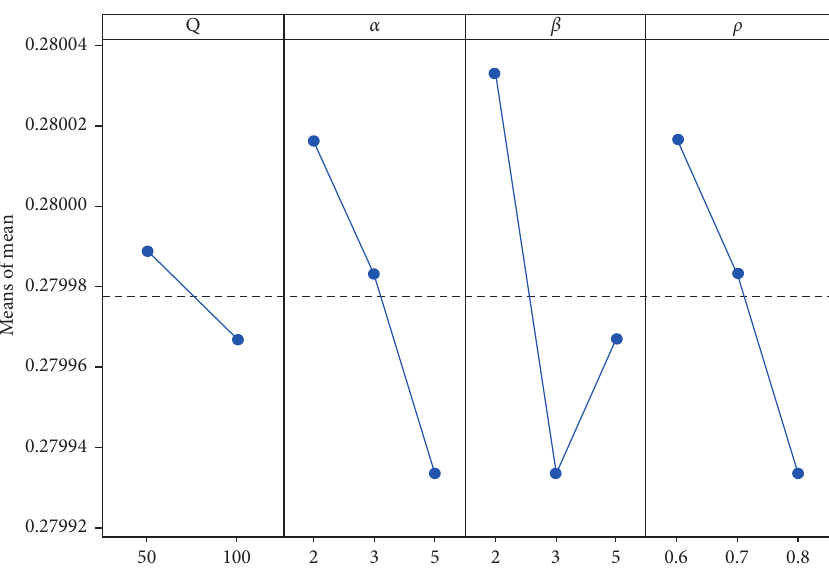
Figure 8: Mean main effect diagram. Table 13: Parameters combination of the four